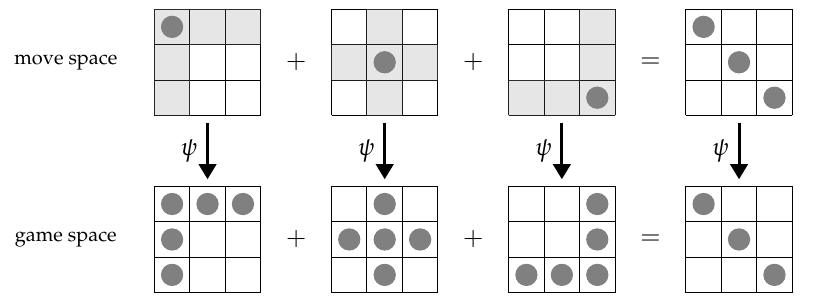
Figure 6. An example of an easy two-state Alien Tiles